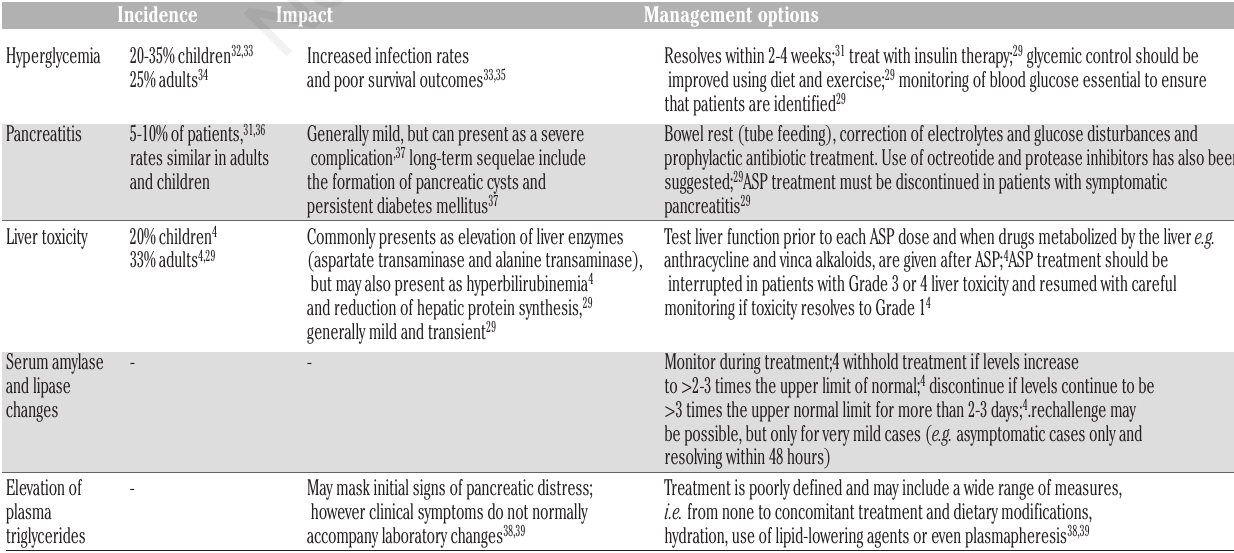
Table 3. Main toxicities related to asparaginase